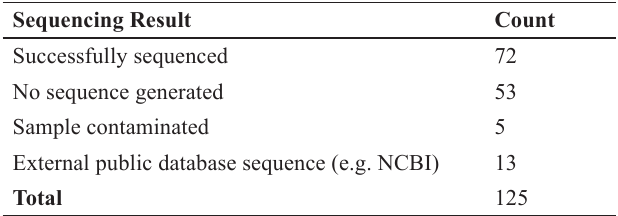
Table 2 . Summary of sample sequencing